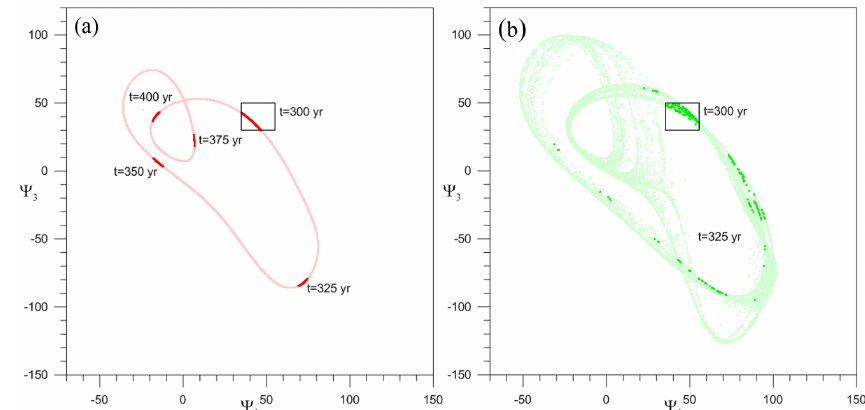
Figure 5. Chaotic and nonchaotic behavior of the autonomous model. (a) Evolution of the 1774 points (red dots) contained at t = 300 years in the black rectangle of Fig. 4c for γ = 1 . 1; the attractor is illustrated by the entire set of 15000 points, shown in light red. (b) Same but for the 135 points (green dots) that lie within the same rectangle for γ = 1 . 35; in this case, the attractor composed of the 15000 points is shown in light green. Due to the chaotic nature of the dynamics in this case, only one snapshot, after 25 years, is